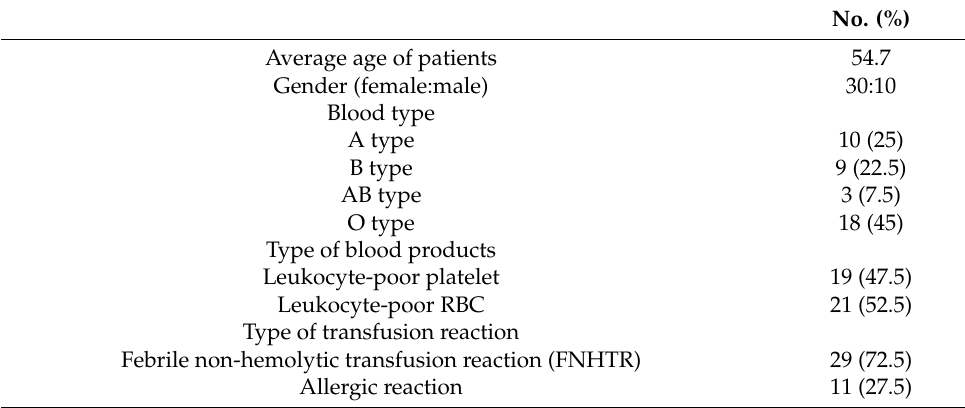
Table 2. Characteristics of patients ( n = 40) with transfusion reaction after transfusing leukoreduced blood